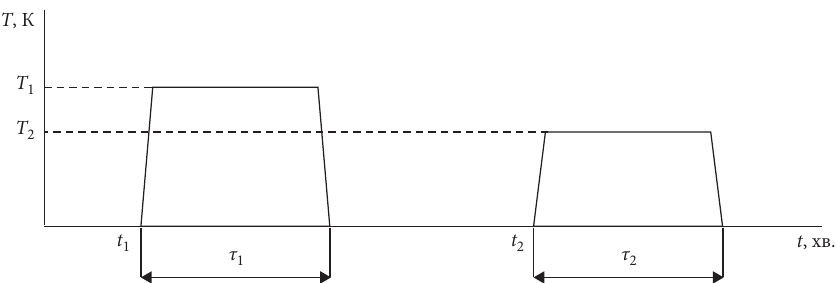
Figure 2: Scheme of heat stepping mode of PCM taking into account the isothermal effects occurring during hardening. Table 2: The parameters of compositions stepping based on epoxide resin hardened by PEPA. # Comp.